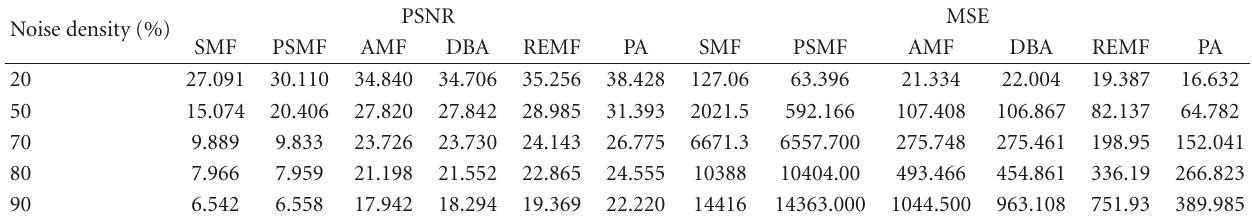
Table 3: PSNR and MSE for various filters for Boat image at di ff erent noise densities.